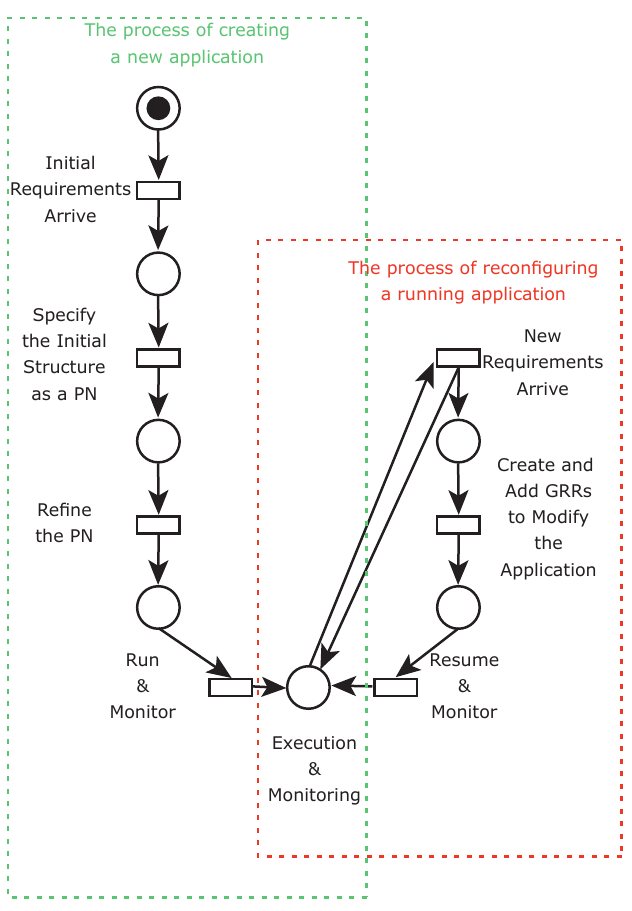
Figure 6. Process of developing and re-configuring an